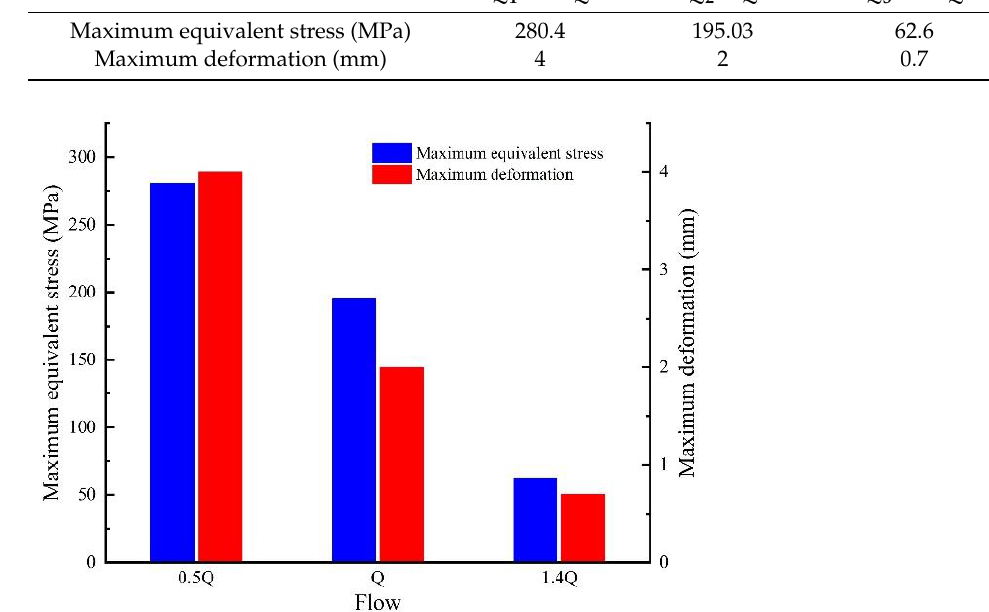
Figure 20. Comparison of maximum equivalent stress and maximum deformation (Q = 20 m 3 /s).